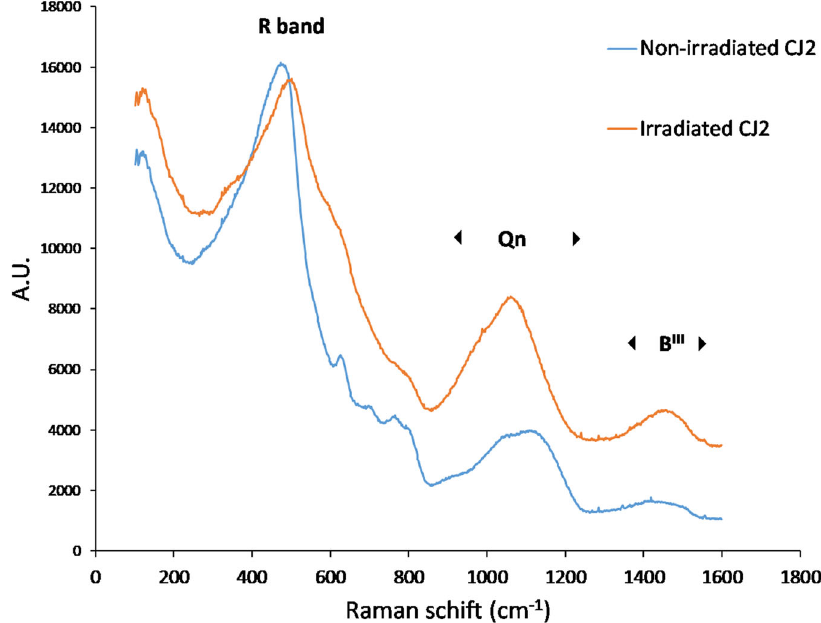
Fig. 1 Raman spectra for the pristine and pre-irradiated CJ2 glass. Analyses from the surface of the glass samples.